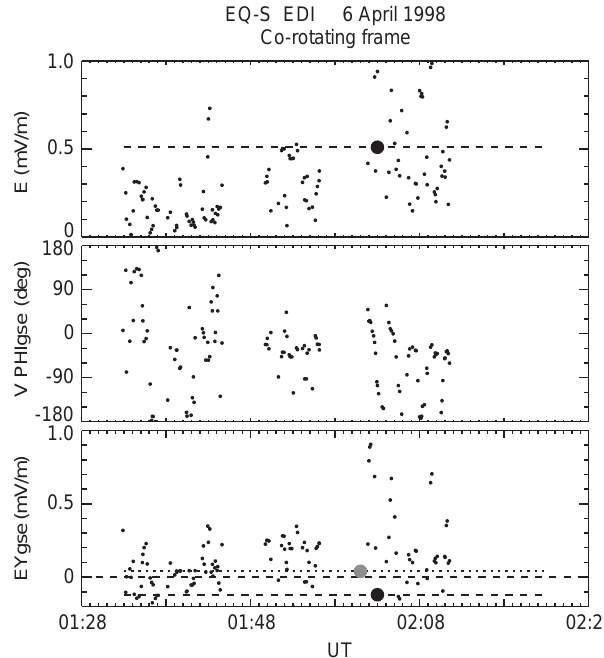
Fig. 6. March 25, 1998 measurements in the co-rotating frame. Same format as Fig. 5. Missing data (22:08–22:12, 22:20–22:24, 22:35– 22:39) are gaps in the EDI triangulation telemetry during diagnostic testing